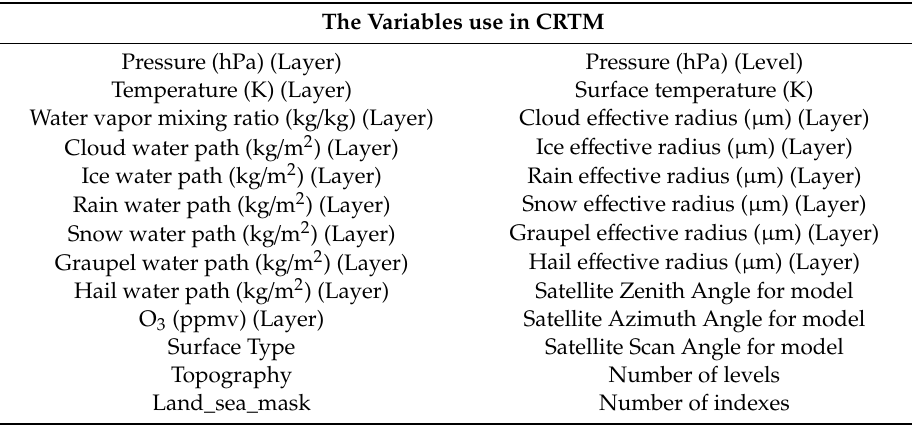
Table 2. The variables used in the CRTM.